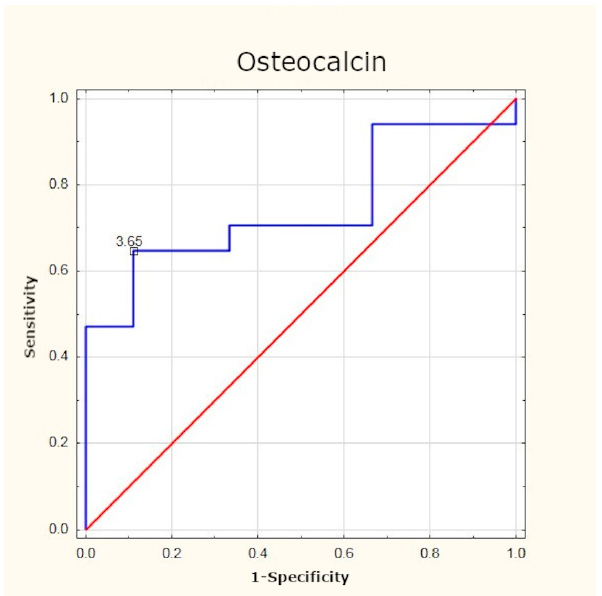
Figure 5. Determination of optimum cut-off point for osteocalcin using ROC curve.